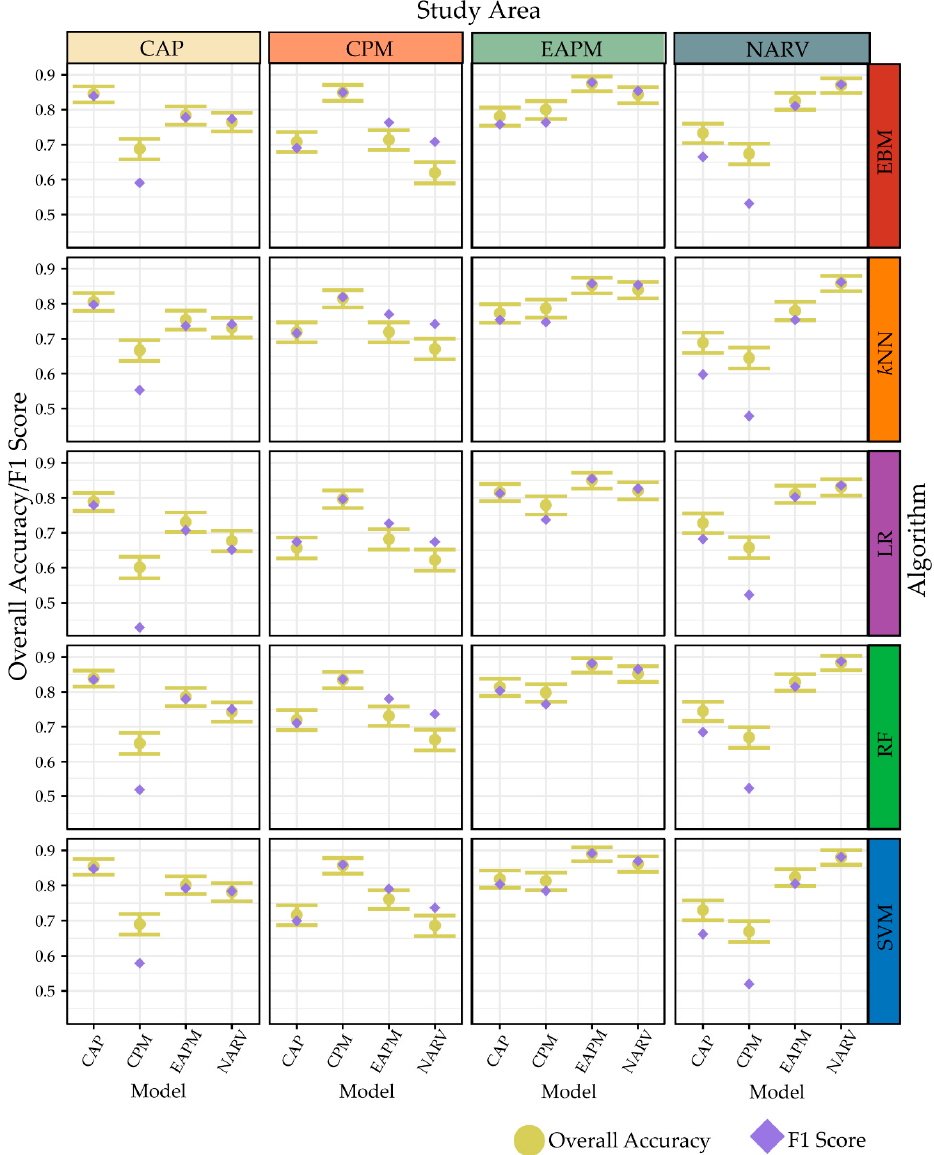
Figure 8. Assessment of model generalization to different MLRAs using OA and F1 score. Bars for OA represent an estimated 95% confidence interval.